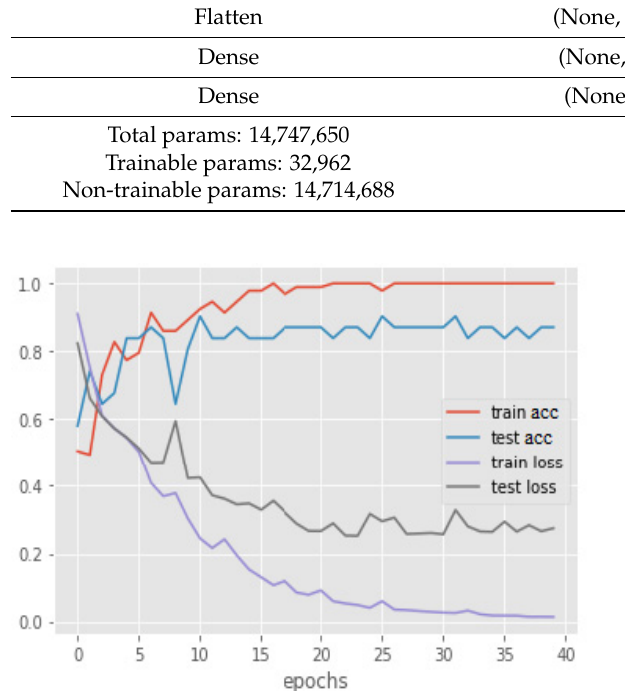
Table A2. Limited-trained model’s summary.